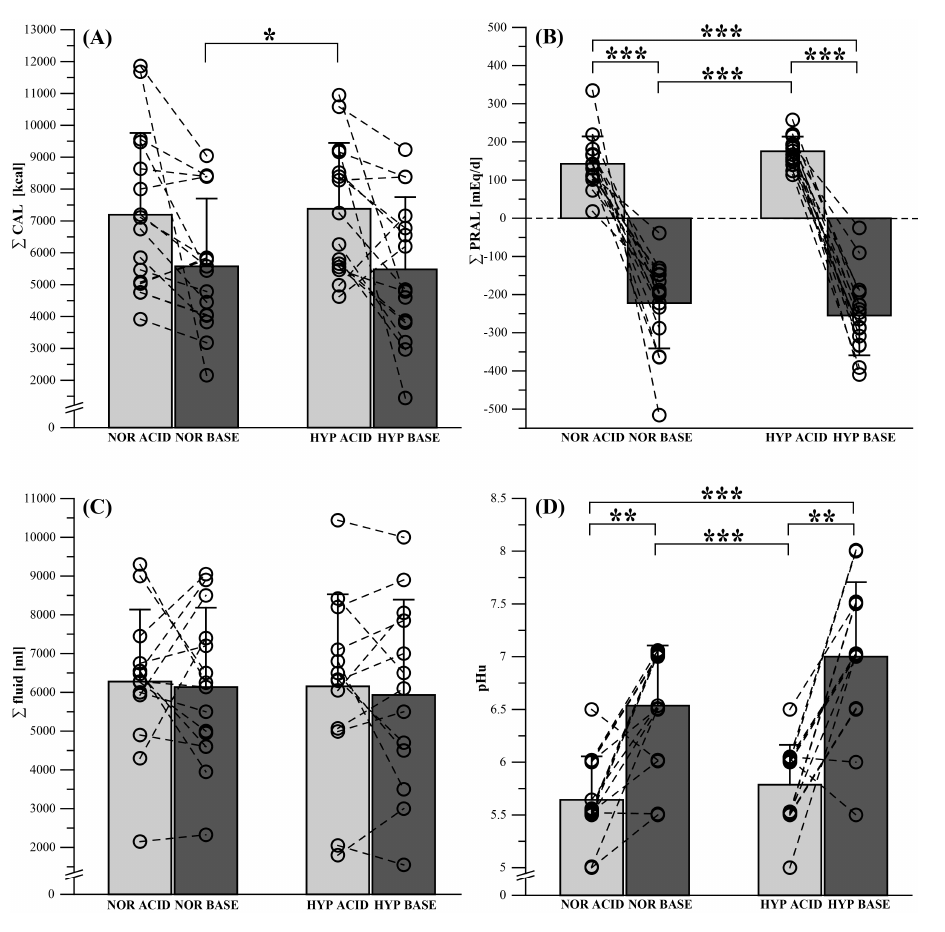
Figure 2. Changes in dietary intervention-related parameters after acidizing (ACID) and alkalinizing (cid:80) (BASE) diet under normoxic (NOR) and hypoxic (HYP) conditions for ( A ) overall caloric intake ( (cid:80) (cid:80) CAL), ( B ) potential renal acid load sum value ( PRAL), and ( C ) overall fluid intake ( fluid), as well as the associated physiological response of ( D ) urinary pH (pH u ). Data points represent individual values ( ). Bar charts are mean ± standard deviation. * p ≤ 0.05, ** p ≤ 0.01, *** p ≤ 0.001. See Section 2. (cid:35) Materials and Methods for further